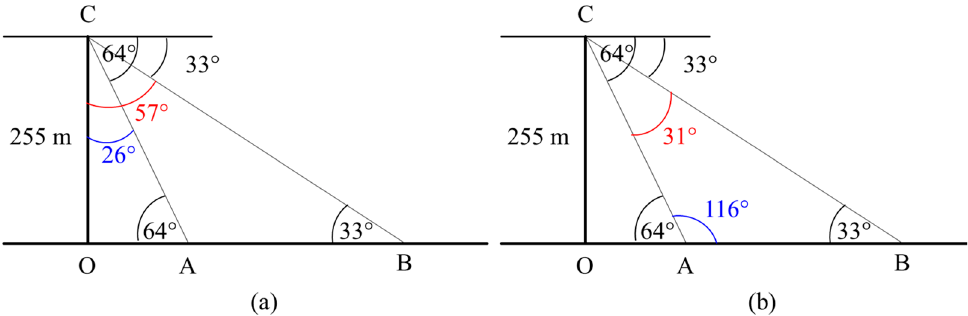
Figure 2. The diagram depicting the scenario of the first word problem. ( a ) By right triangles, and ( b ) by mixing right and oblique triangles.